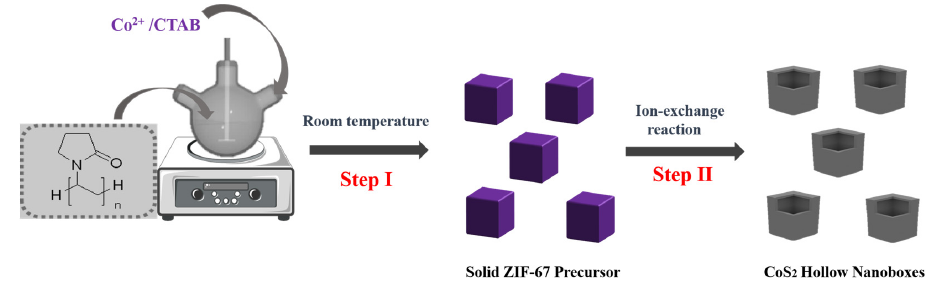
Figure 1. Schematic illustration for the preparation of CoS 2 hollow nanoboxes.